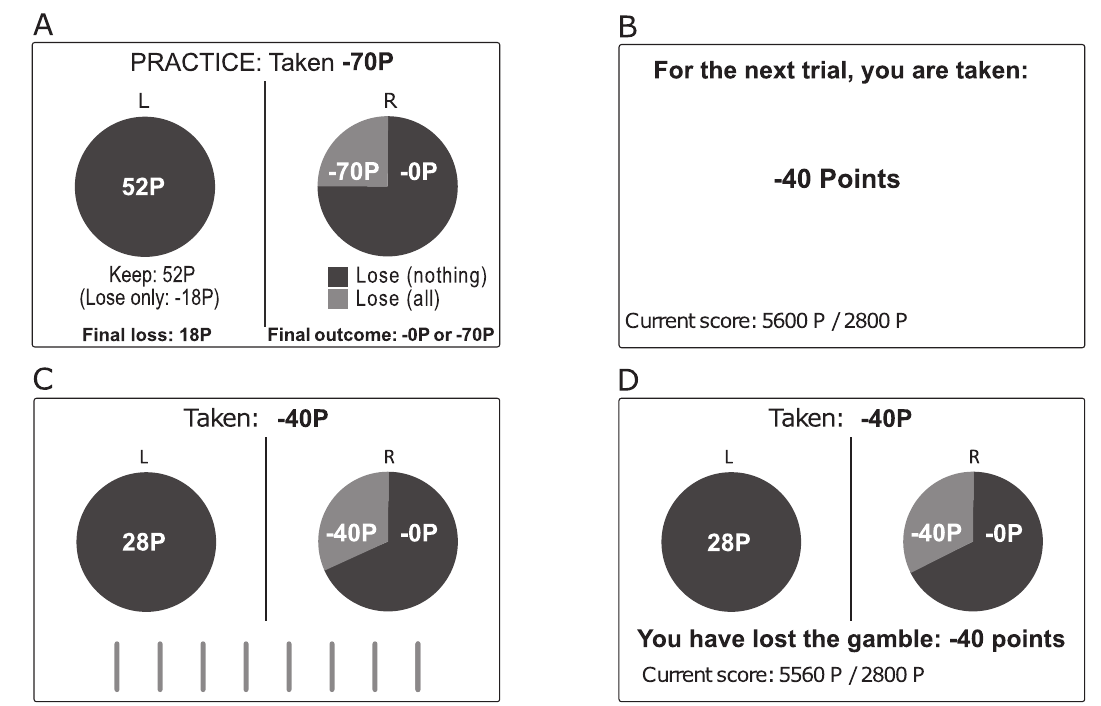
Fig 2. Example of a guided practice trial (panel A) and timeline for one trial in a gain-frame (panel B-D). The screen displaying the amount of points initially taken was presented for 2.5s (panel B). It also displayed the induced need for the block of trials and the remaining budget. The screen displaying the choice options was presented for either 1s or 3s, depending on the experimental condition (panel C). The bars below the pie-charts indicate the available time for making a choice (speed by which the bars were removed). The feedback screen (panel D) announced the result of the decision, the remaining budget, and the need target. It was presented for